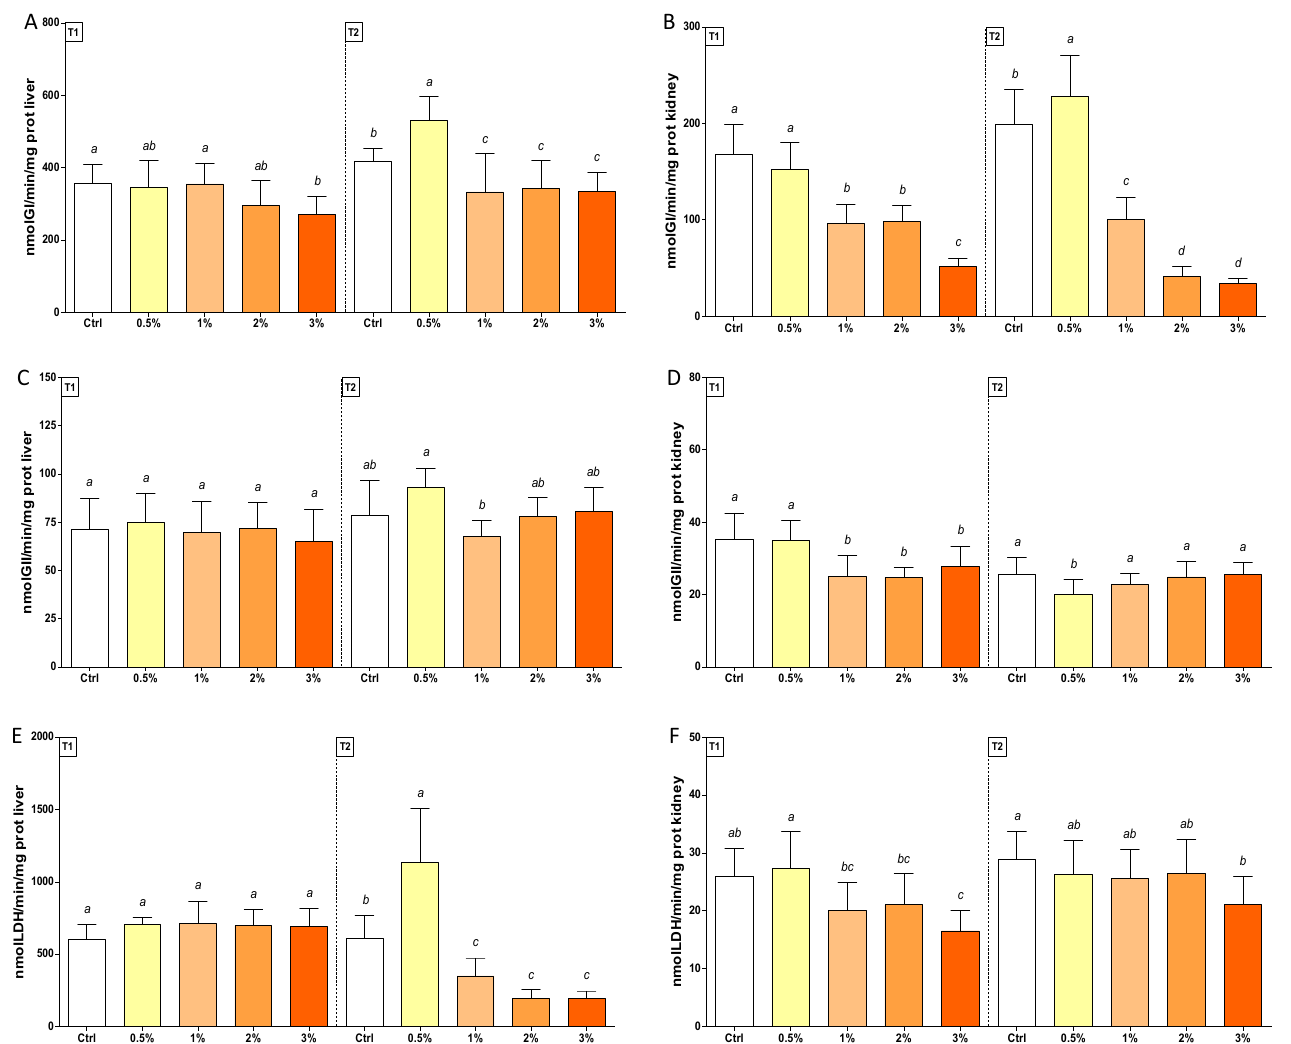
Figure 4. Enzymatic activity of GI (Panel ( A , B )), GII (Panel ( C , D )), and LDH (Panel ( E , F )) in livers (on the left, Panel ( A , C , E )) and kidneys (on the right, Panel ( B , D , F )) of rainbow trout Oncorhynchus mykiss fed with F1-BEO-supplemented diets (0.5%, 1%, 2%, 3% ( w / w ) supplementation) after 15 (T1) and 30 (T2) days. Different lowercase letters indicate statistically significant differences among experimental groups ( p < 0.05) for each experimental endpoint.